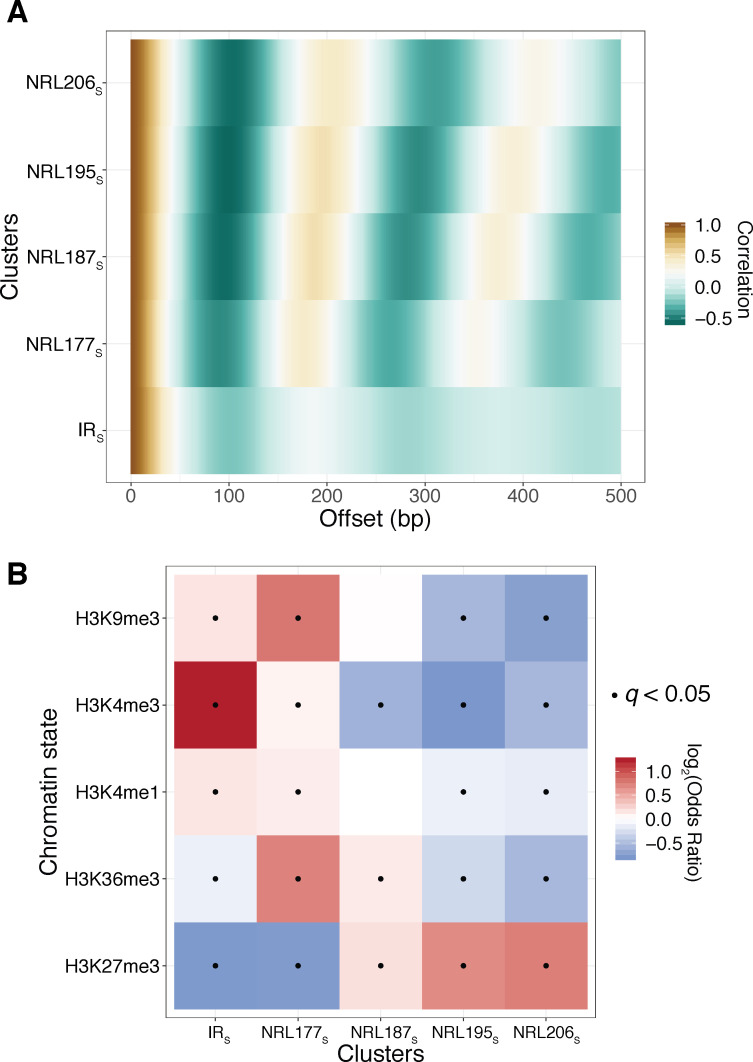
Reanalysis of the Fiber-seq data of Stergachis et al validates SAMOSA-based findings of our initial submission.A) We obtained and reanalyzed K562 data produced using the Fiber-seq protocol using our analytical pipeline. We clustered fibres based on autocorrelograms using leiden clustering, resulting in five discrete clusters, labeled with the XS notation to distinguish them from clusters defined using SAMOSA data. (B) In agreement with our own SAMOSA-based findings, we find that H3K9me3 decorated chromatin is enriched in irregular chromatin fibres and short NRL fibres, while e.g. H3K27me3 decorated chromatin is enriched for long NRL fibres.